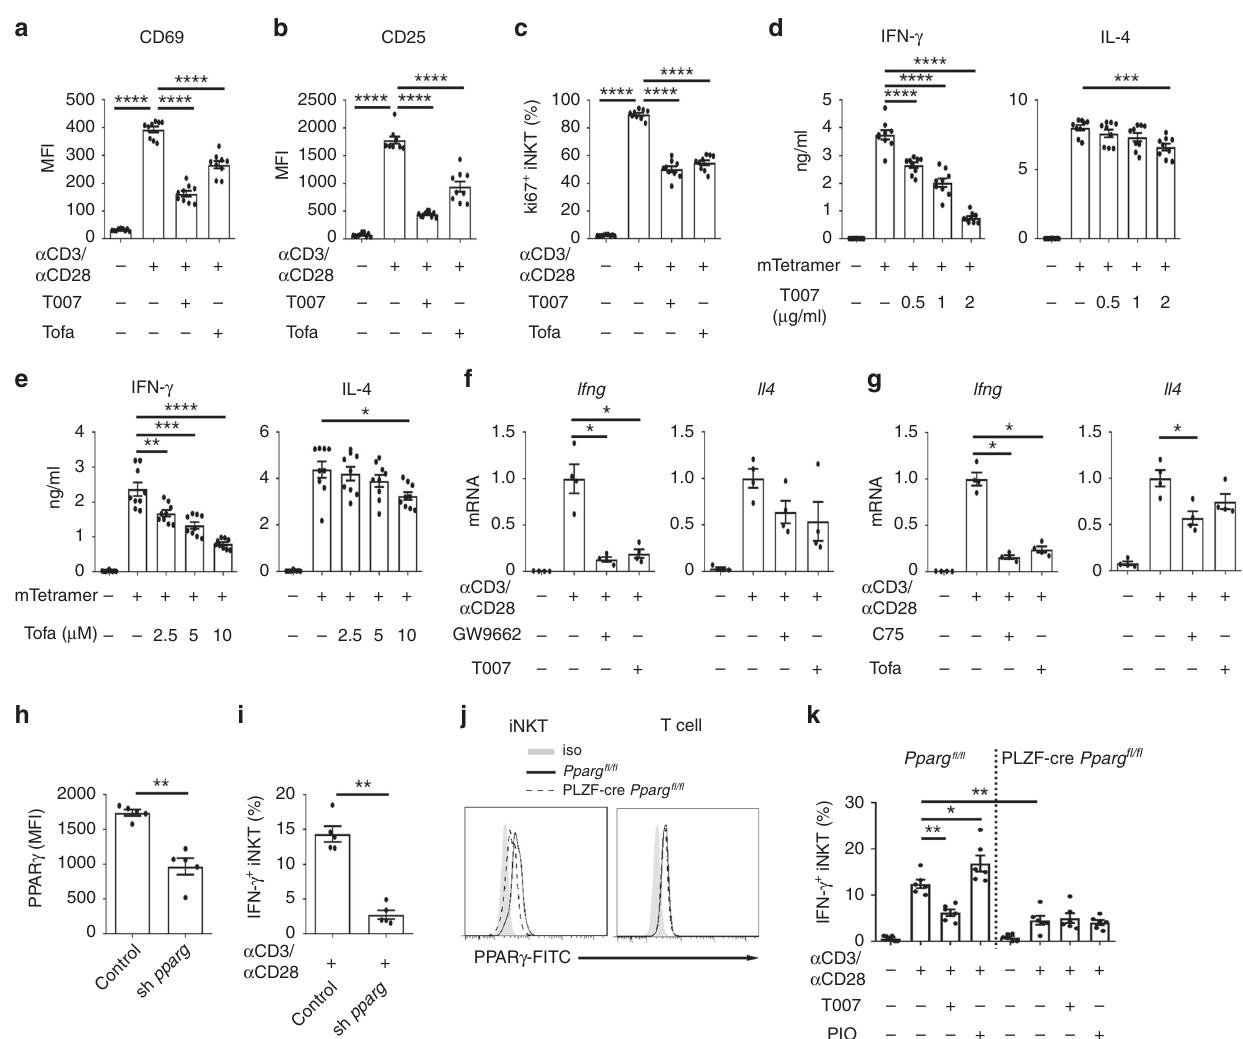
Fig. 2 PPAR γ and lipid synthesis promote activation and IFN- γ production of iNKT cells. a , b Surface CD69 ( a ), CD25 ( b ) on iNKT cells after activating by plate-coated anti-CD3 and anti-CD28 in the absence or presence of T007, Tofa. Unstimulated iNKT cells were used as negative controls. c Frequencies of Ki67 + iNKT cells after activating with plate-coated anti-CD3 and anti-CD28 for 2 days with or without T007, Tofa. d IFN- γ and IL-4 production in iNKT cells activated by plate-coated mCD1d-PBS57 tetramer in the absence or presence of T007. e IFN- γ and IL-4 production in iNKT cells in the absence or presence of Tofa as described in d . f , g mRNA of Ifng and Il4 in iNKT cells activated by anti-CD3 plus anti-CD28 for 24 h with or without antagonists of PPAR γ ( f ) or fatty acid synthesis inhibitors ( g ). h , i Knockdown ef fi ciency of Pparg shRNA ( h ) and its effect on percentages of IFN- γ + iNKT cells, after activating with plate-coated anti-CD3 and anti-CD28 ( i ). j PPAR γ expression in iNKT cells or T cells from PLZF-cre Pparg fl / fl mice or Pparg fl / fl mice. k Percentages of IFN- γ + iNKT cells from PLZF-cre Pparg fl / fl mice or Pparg fl / fl mice, after activating with plate-coated anti-CD3 and anti-CD28 with or without T007, or PIO. Data are representative of six mice ( j ), or are means ± SEM of three independent experiments ( h , i ), nine biological replicates ( a – e ), four independent experiments ( f , g ), or six mice ( k ), pooled from three to four independent experiments. Data were analyzed by unpaired Student ’ s t -test ( a – e ) or Mann-Whitney test ( f – i , k ). * P < 0.05, ** P < 0.01, *** P < 0.001, **** P < 0.0001. Source data are provided as a Source Data fi